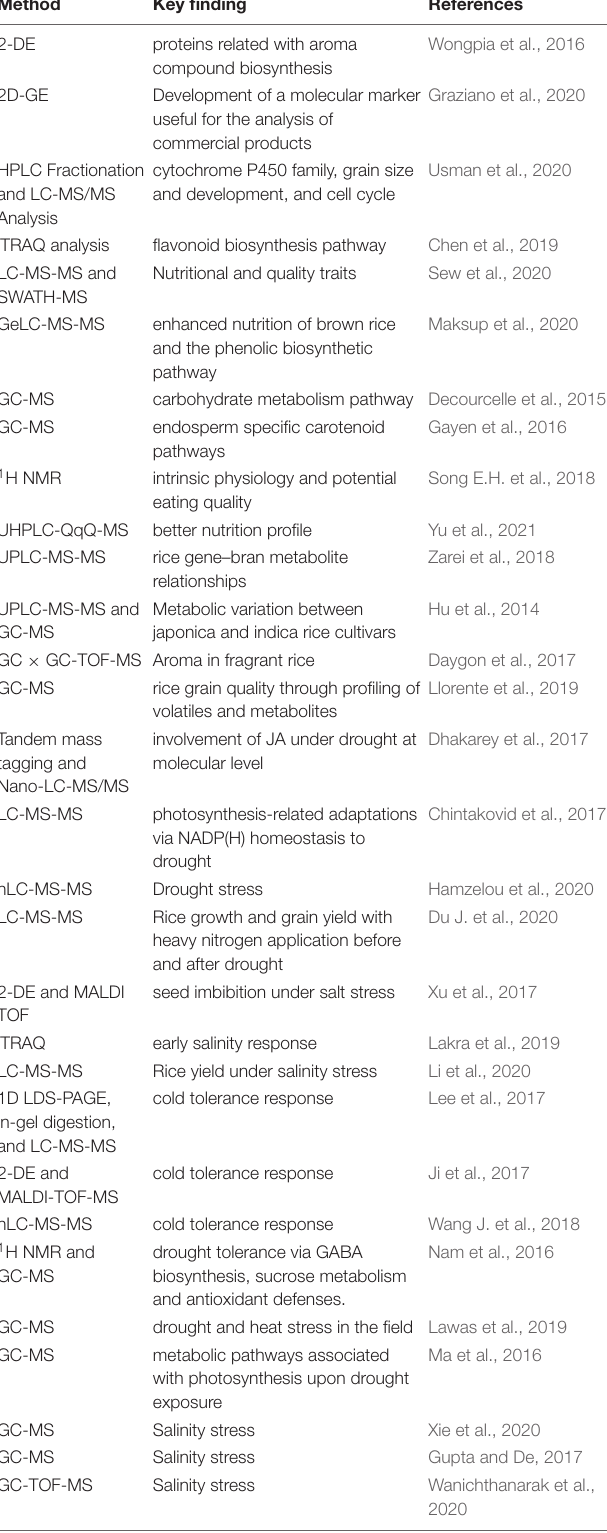
TABLE 3 | List of proteomics and metabolomics techniques in rice trait improvement and stress